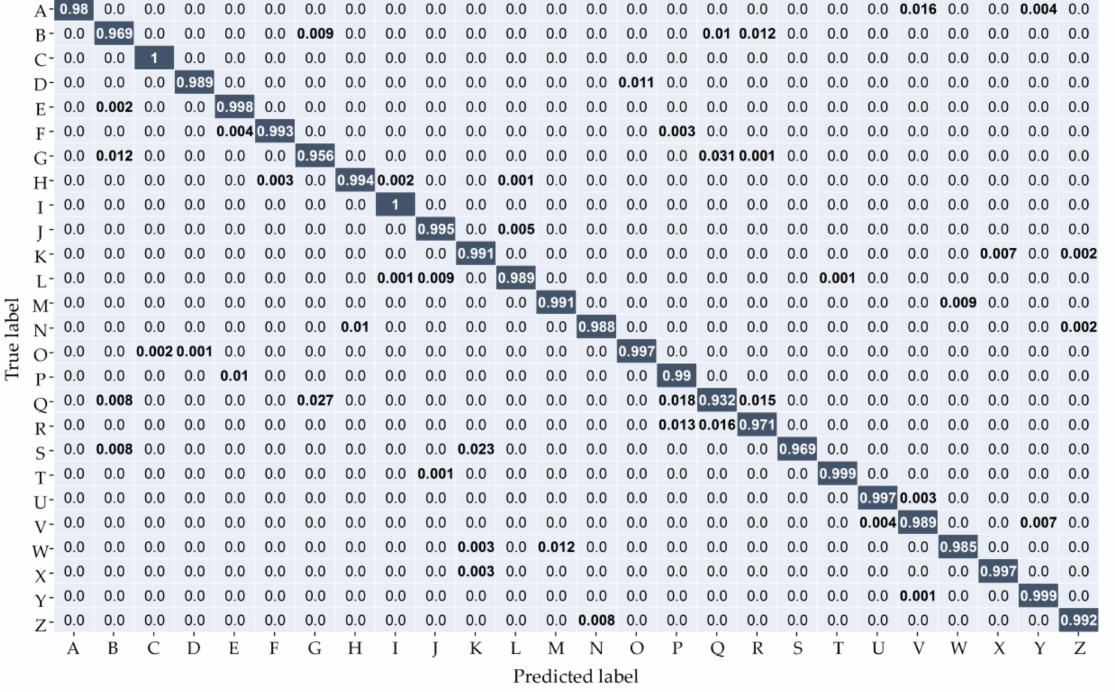
Figure 6. Confusion matrices of